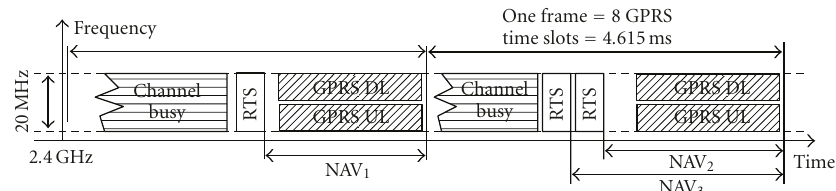
Figure 16: GPRS and WiFi time sharing the ISM